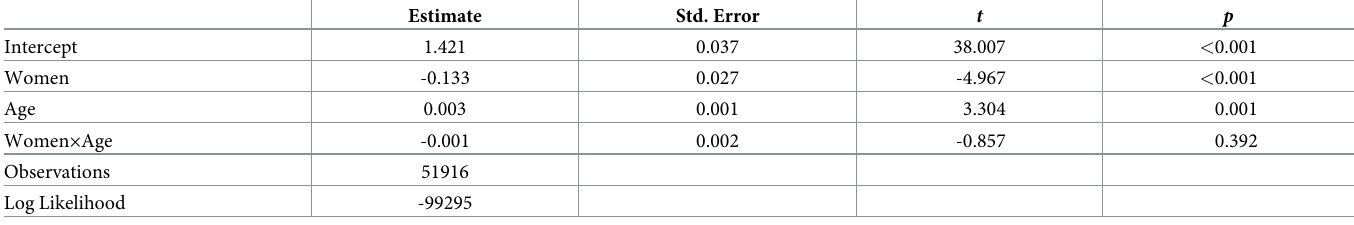
Table 5. Mixed effects models predicting February-May 2020 changes in the number of submissions of COVID-related manuscripts in health & medicine